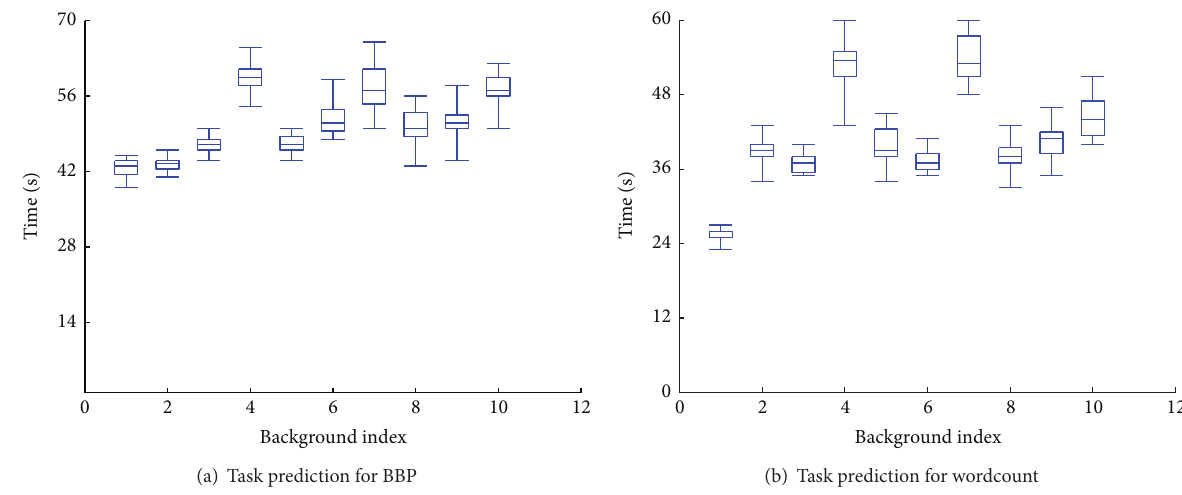
Figure 15: Execution time